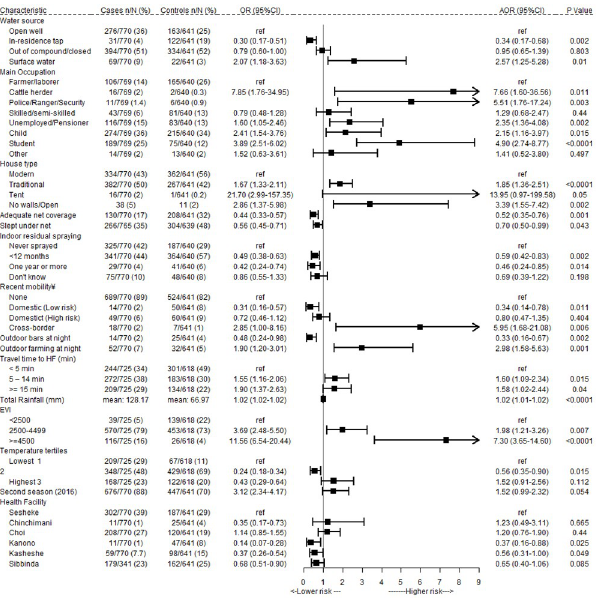
Fig 4. Unadjusted and adjusted odds ratios for selected exposures associated with the risk of symptomatic malaria in Zambezi Region, adjusting for matching variables (age, gender, calendar quarter).